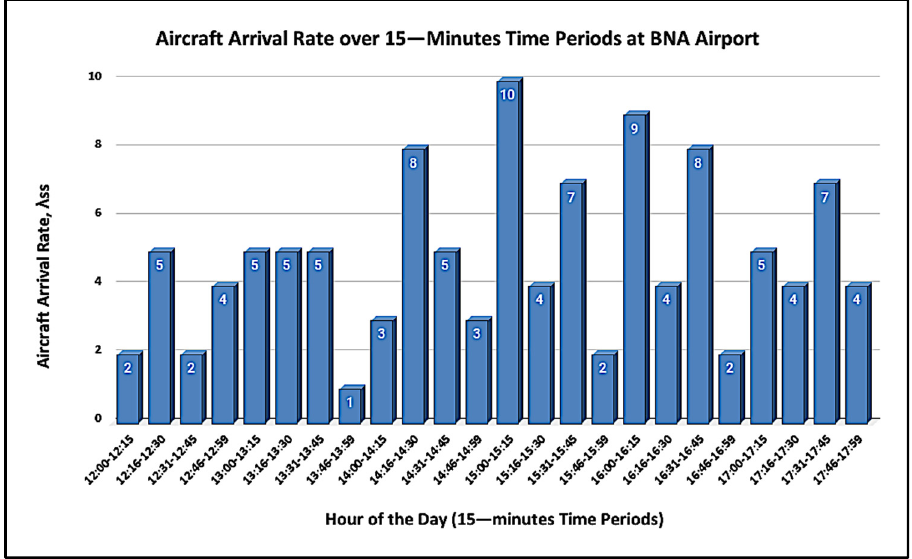
Figure 7. The number of aircrafts arriving in each time period at BNA airport.